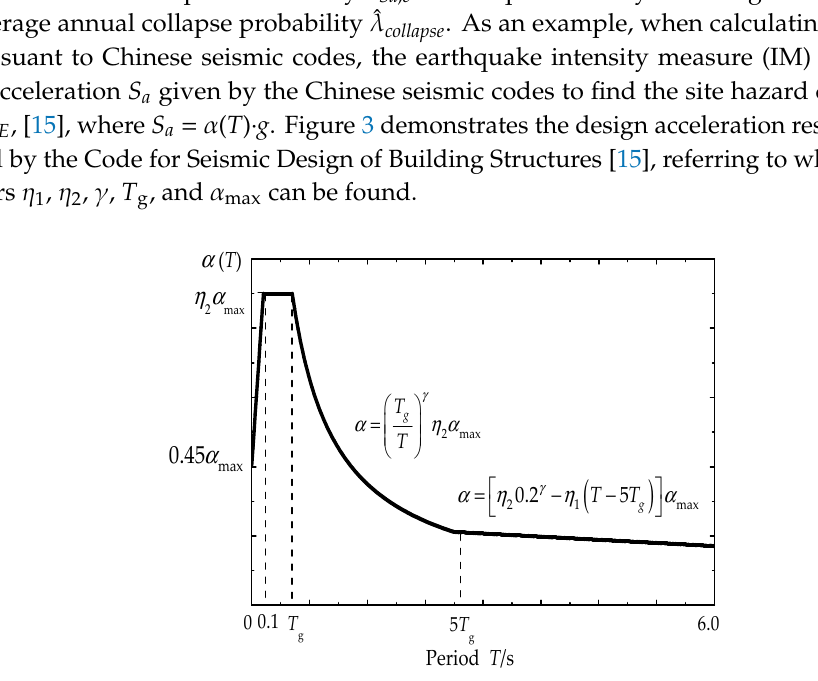
Figure 3. Design acceleration response spectrum.